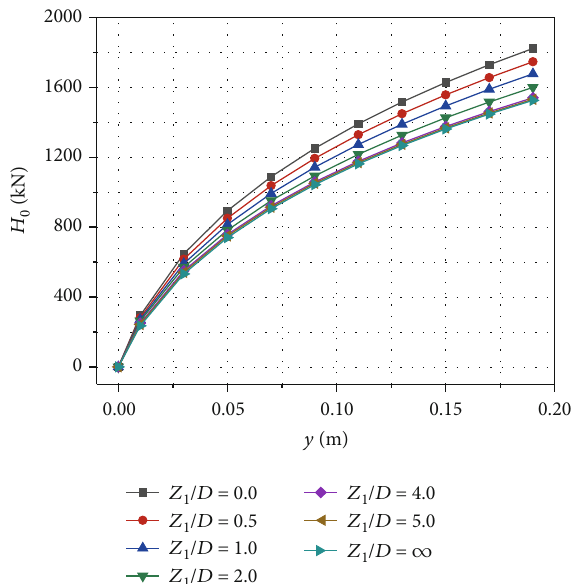
Figure 19: E ff ect of Z